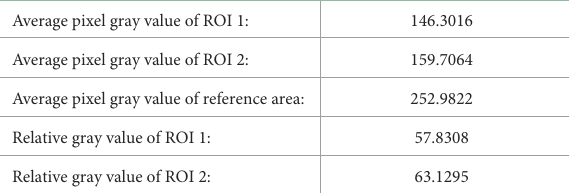
TABLE 2 Relevant calculation data for quantitative analysis of echo intensity of white matter in plane two.